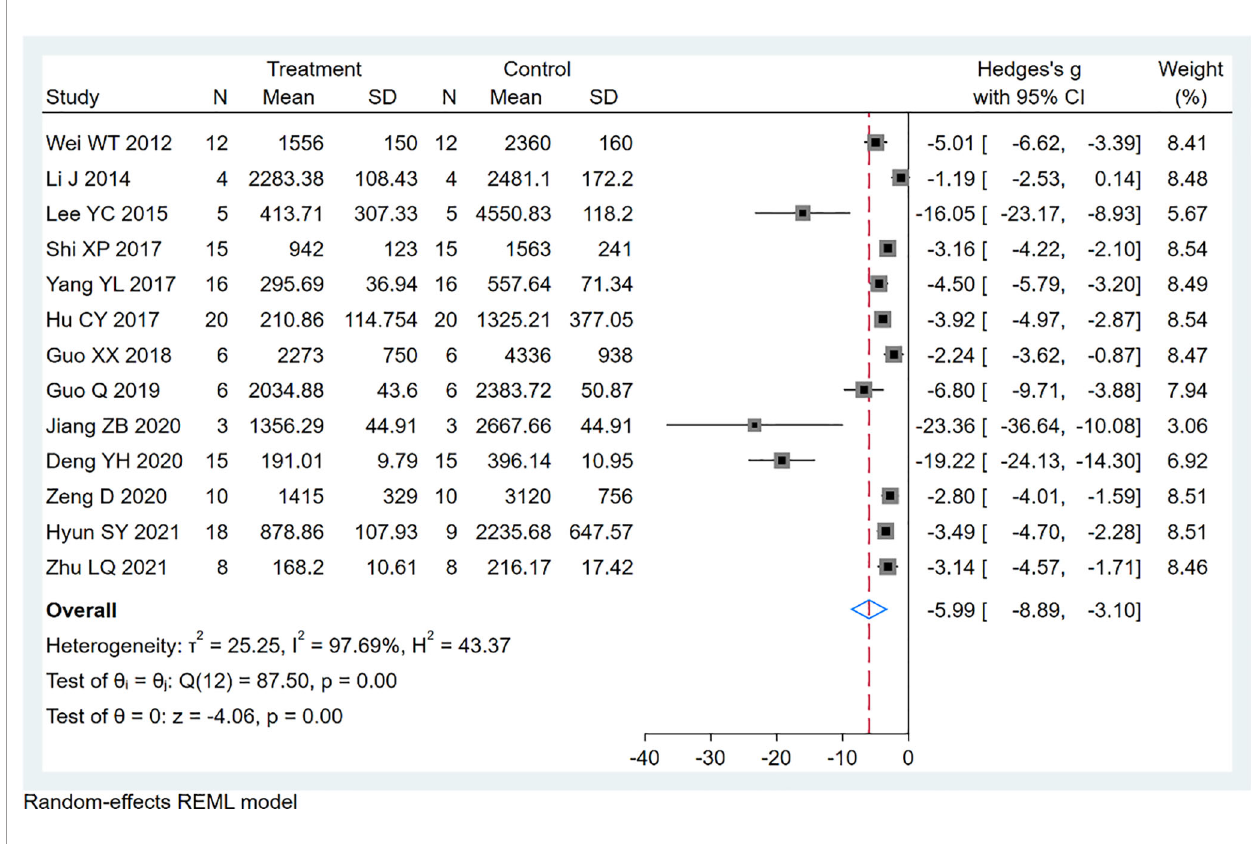
FIGURE 4 | Forest plot of tumor volume.